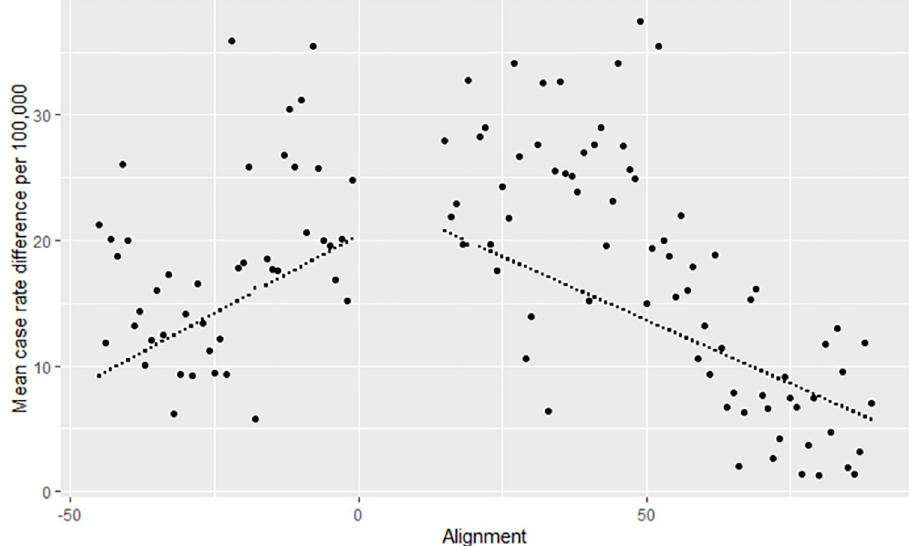
Fig 2. Difference in case rates per 100,000 population, between municipalities with mask mandates vs. those without